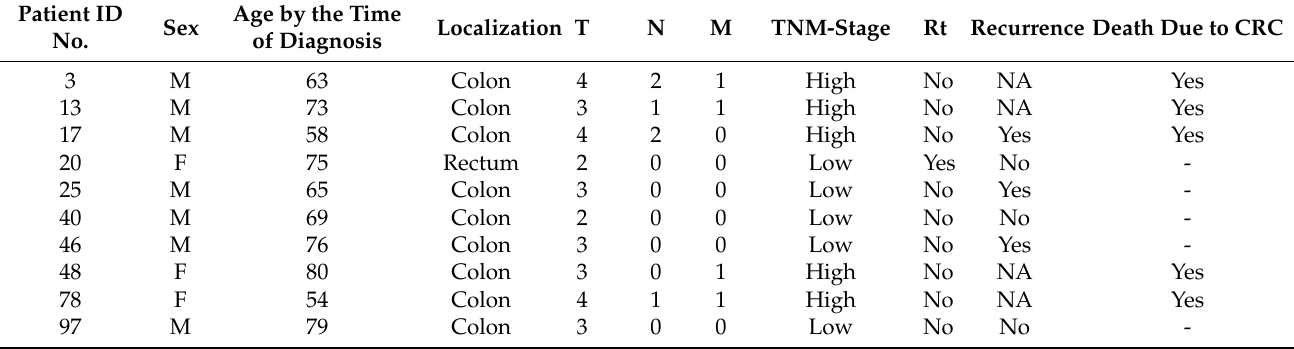
Table 1. Patient